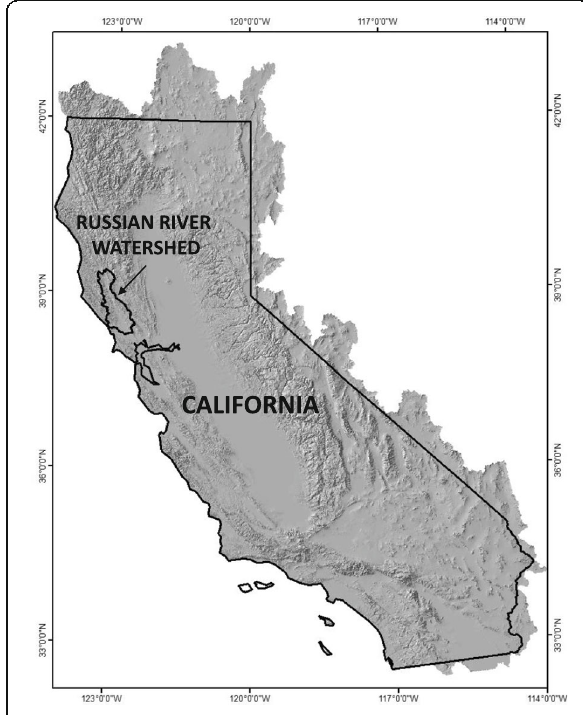
Fig. 1 Study area, indicating the state of California, the boundaries of watersheds draining into the state in gray shaded relief, and the Russian River watershed